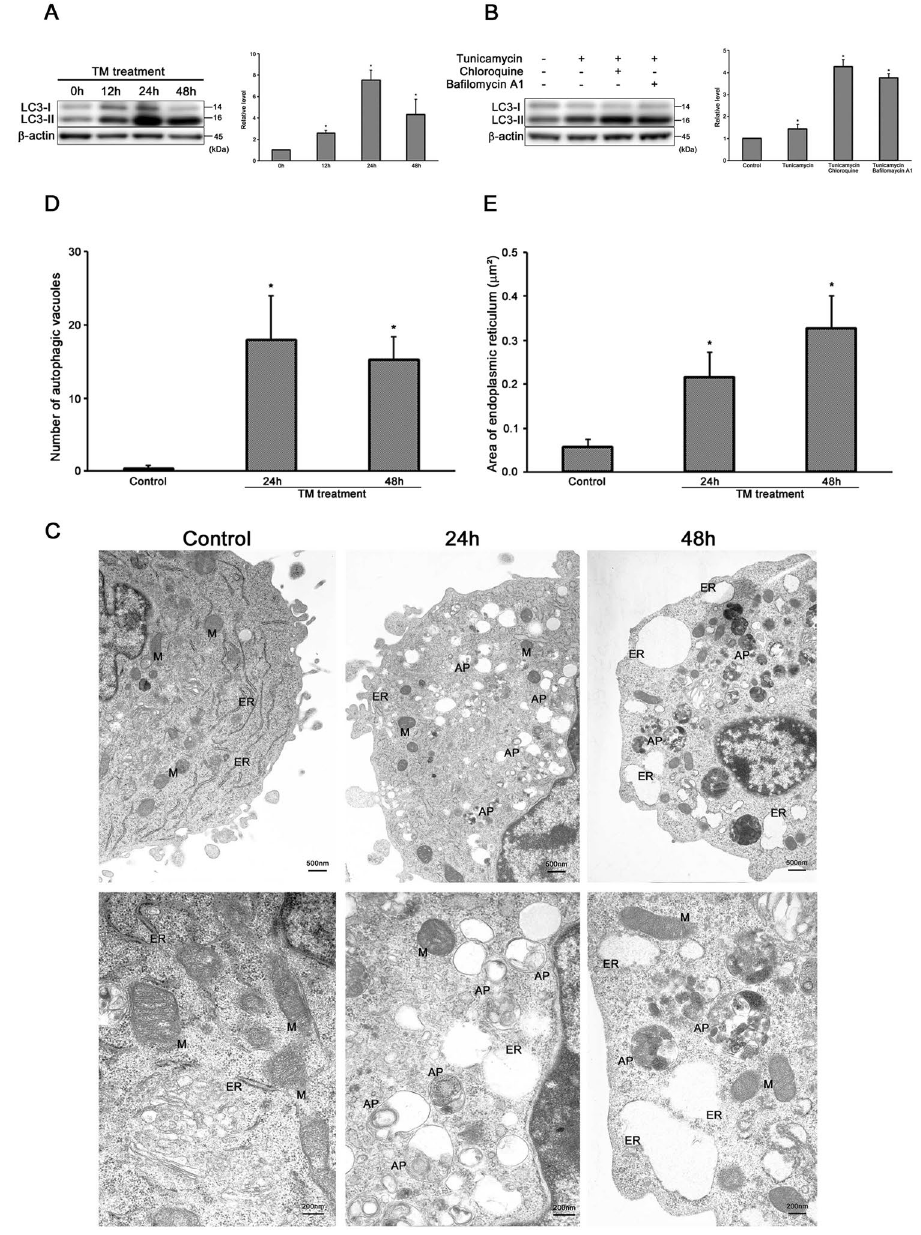
Figure 3. ER stress induces autophagy in auditory cells. ( A ) Representative Western blots showing the expressions of LC3-II. β -actin was included as a loading control. The expression of LC3-II was detected, and the means ± S.D. (fold of changes over the control group) of three or more independent studies were presented ( * p < 0.05 versus control group). Full-length blots are presented in Supplementary Figure 3a and b. ( B ) Cells were treated with 50 µ g/ml tunicamycin in the presence of chloroquine (50 µ M) or bafilomycin A1 (100 nM) for 24 h, and subjected to Western blots analysis. The expressions of LC3-II in tunicamycin-treated cells was markedly increased by lysosomal inhibitors. β -actin was included as a loading control. The expression of LC3-II was detected, and the means ± S.D. (fold of changes over the control group) of three or more independent studies were presented ( * p < 0.05 versus control group). Full-length blots are presented in Supplementary Figure 3c and d. ( C ) Representative transmission electron microscopy shows morphological changes in HEI-OC1 cells treated with tunicamycin (50 µ g/ml for 24 h and 48 h). The structure of the nucleus and organelles are normal in control cells (left panel, × 10,000). Treated cells with tunicamycin (50 µ g/ml for 24 h) leads to the formation of autophagosome and mild ER expansion (middle panel, × 10,000). Treated cells with tunicamycin (50 µ g/ml for 48 h) exhibits some autophagosomes and hyper ER expansion (right panel, × 10,000). M, mitochondria; ER, endoplasmic reticulum; AP, autophagosome. ( D ) The number of autophagic vacuoles was counted per one cell, which was presented as the mean ± S.D. from three or more independent experiments ( * p < 0.05 versus control group). ( E ) The area of ER was measured per one ER, which was presented as the mean ± S.D. from three or more independent experiments ( * p < 0.05 versus control